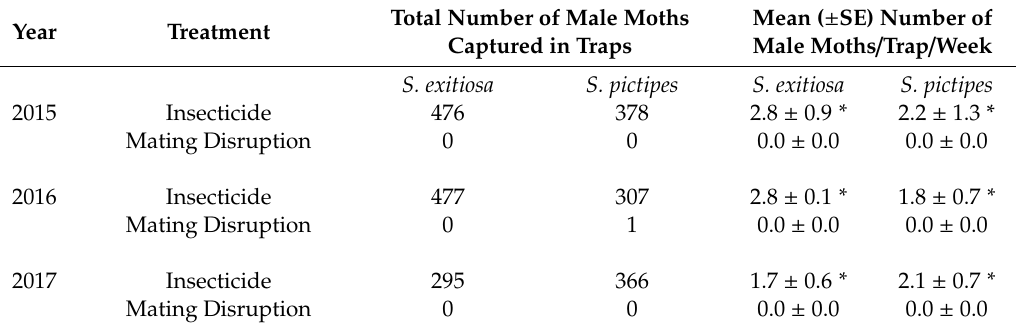
Table 1. Total and mean ( ± SE) number of male S. exitiosa and S. pictipes captured in pheromone baited traps deployed in insecticide and mating disruption plots in 2015–2017.